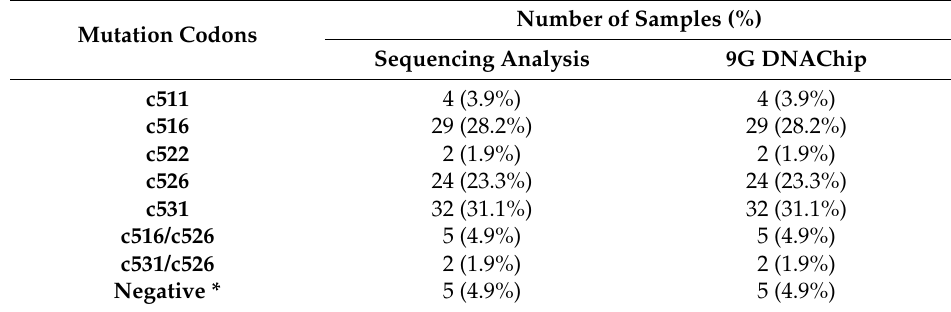
Table 2. Outcomes of sequencing analysis and 9G DNAChip in 103 rifampin-resistant